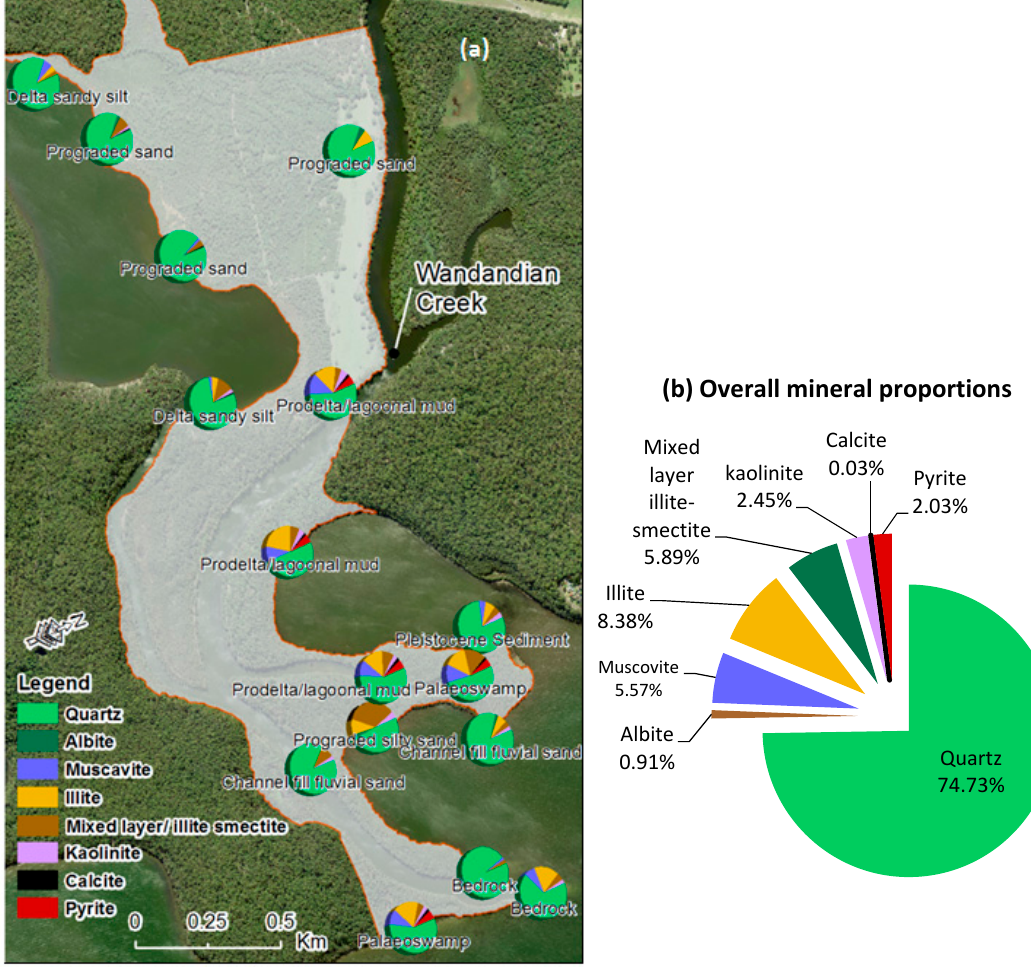
Figure 12. Soil and sediment samples from the Wandandian deltaic landform, illustrating: ( a ) mineral contents in each sediment sample and represented facies, with a clear dominance of quartz, ( b ) the overall mineral proportions in the sediment samples. (The background is from a Jervis Bay 50 cm Orthorectified Image obtained from LPI for January 2014 [30]).